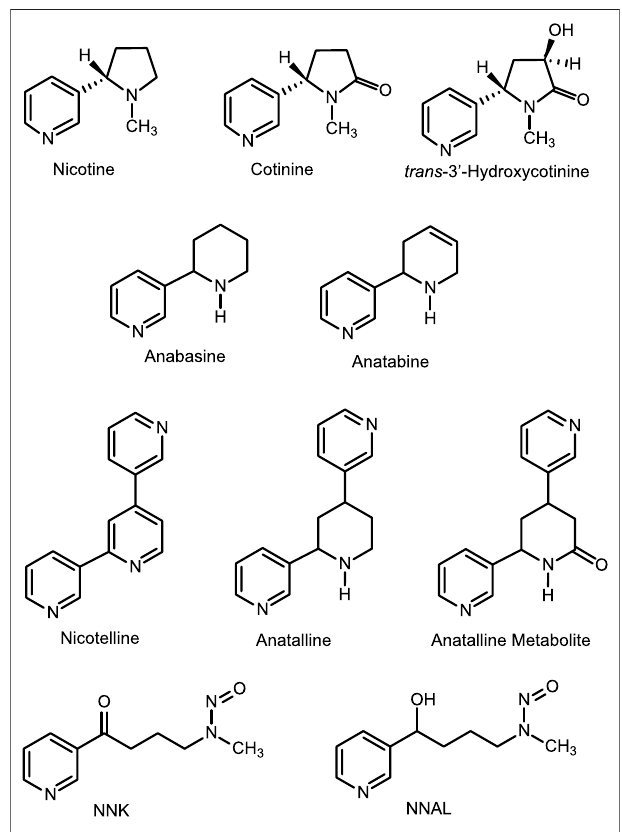
FIGURE 1 | Biomarkers and biomarker metabolic precursors.